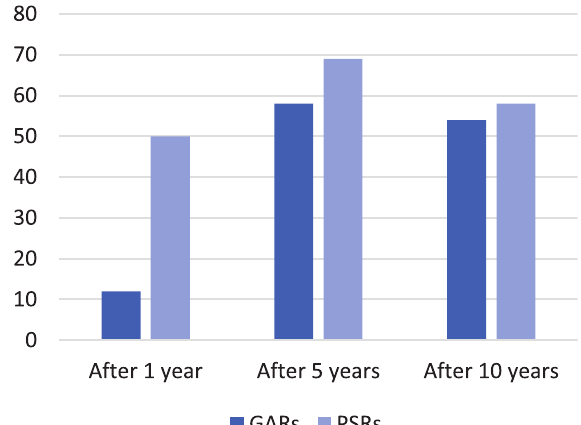
Figure 2. Employment rates of resettled refugees in Canada